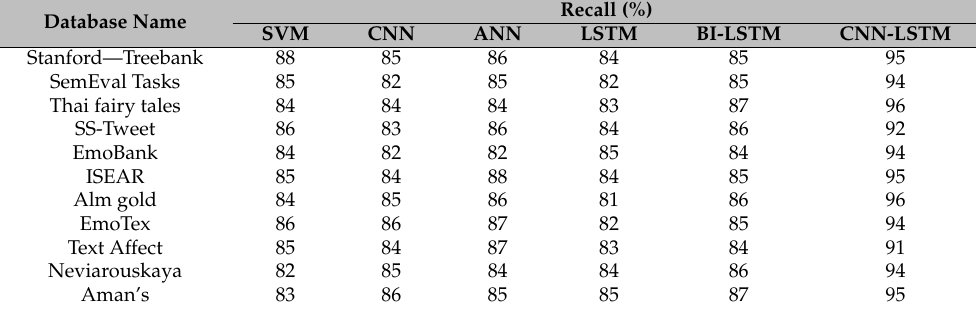
Figure 11. Performance analysis for BOW + IF-IDF with CNN-LSTM based on recall. (“Stanford Sentiment...” means “Stanford Sentiment Treebank”). Table 6. Performance analysis for BOW + IF-IDF with CNN-LSTM based on